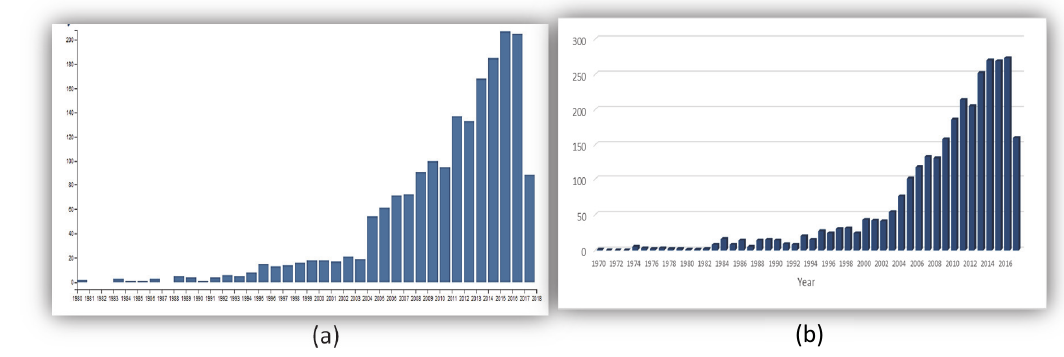
Fig. 1. The trend of publications with topic of “simulation optimization” in (a) the Web of Science databases (source: WoS, Data retrieved on August 2017), and (b) SCOPUS (source: Scopus, Data retrieved August